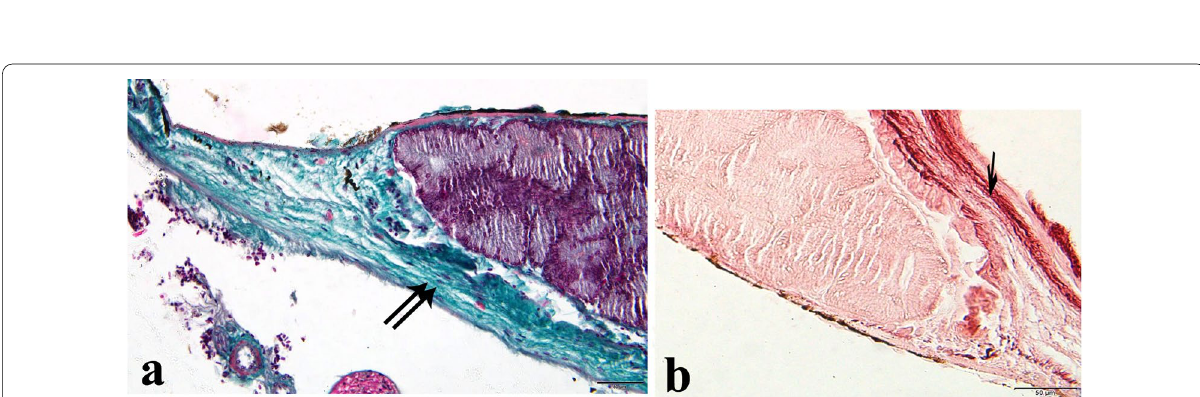
Fig. 4 A photomicrograph of a transverse section of the Harderian gland of Egyptian agama, Trapelus mutabilis , showing the connective tissue capsule of the Harderian gland contains collagen fibers (double arrows) and elastic fibers (arrow) (a, Masson’s trichromic, b, Orcein,